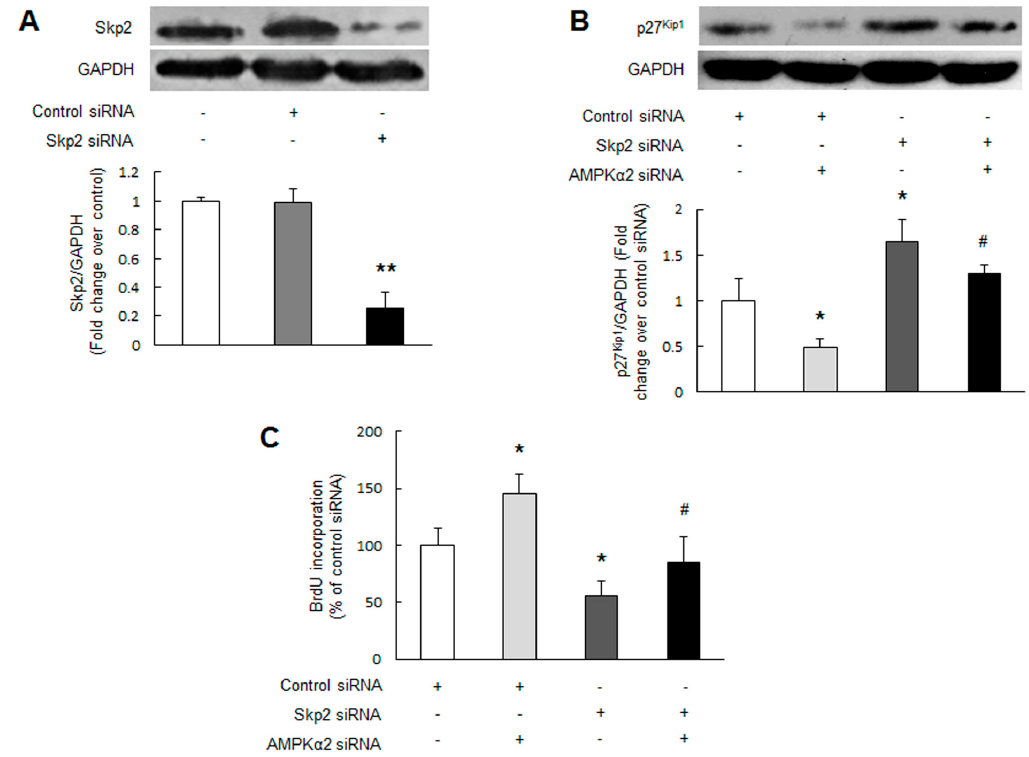
Figure 4. Skp2 mediates AMPK α 2 knockdown-induced p27 Kip1 reduction and PASMCs proliferation. ( A ) Primary cultured PASMCs were transfected with Skp2 sequence-specific siRNA and non-targeting siRNA, the silencing efficiency was assessed by immunoblotting ( n = 3 in each group); ( B , C ) PASMCs were transfected with non-targeting siRNA or Skp2 specific siRNA, and followed with or without AMPK α 2 siRNA transfection. Protein level of p27 Kip1 was examined using immunoblotting ( B ) ( n = 3 in each group). Cell proliferation was measured by BrdU incorporation assay ( C ) ( n = 4 in each group). +, with indicated siRNA transfection; − , without siRNA transfection; * p < 0.05 versus control siRNA transfection; ** p < 0.01 versus control siRNA transfection; # p < 0.01 versus control siRNA + AMPK α 2 siRNA transfection.